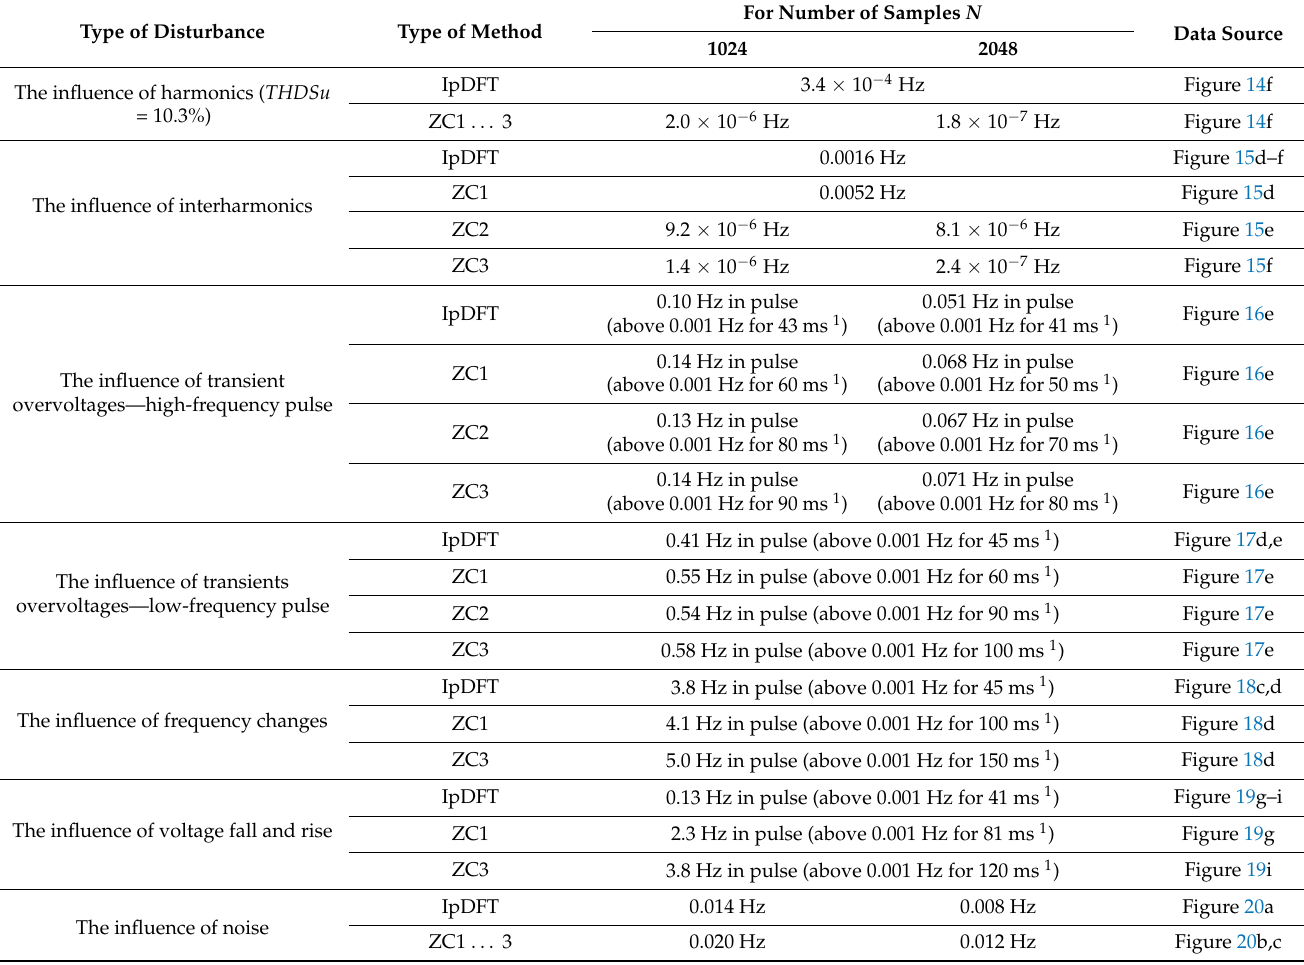
Table 6. Maximum frequency estimation level errors for the grid disturbances described in Section 5. For two cases of N (1024 and 2048), NT = 50ms and for the presented IpDFT method with the use of GMSD window with parameter m = 3 and the reference zero-crossing method (ZC1 for one 6th-order filter section, ZC2 and ZC3—for two and three, respectively, filter